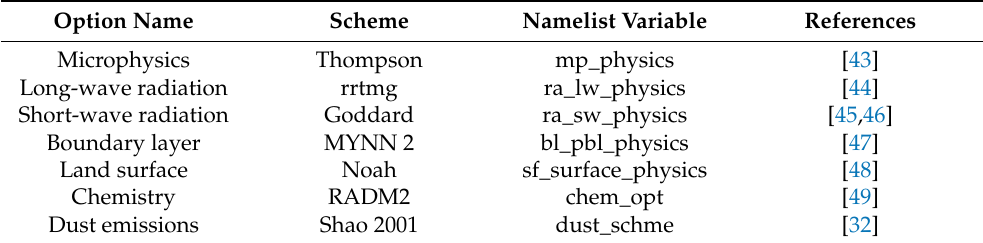
Table 1. WRF-Chem physics and chemistry